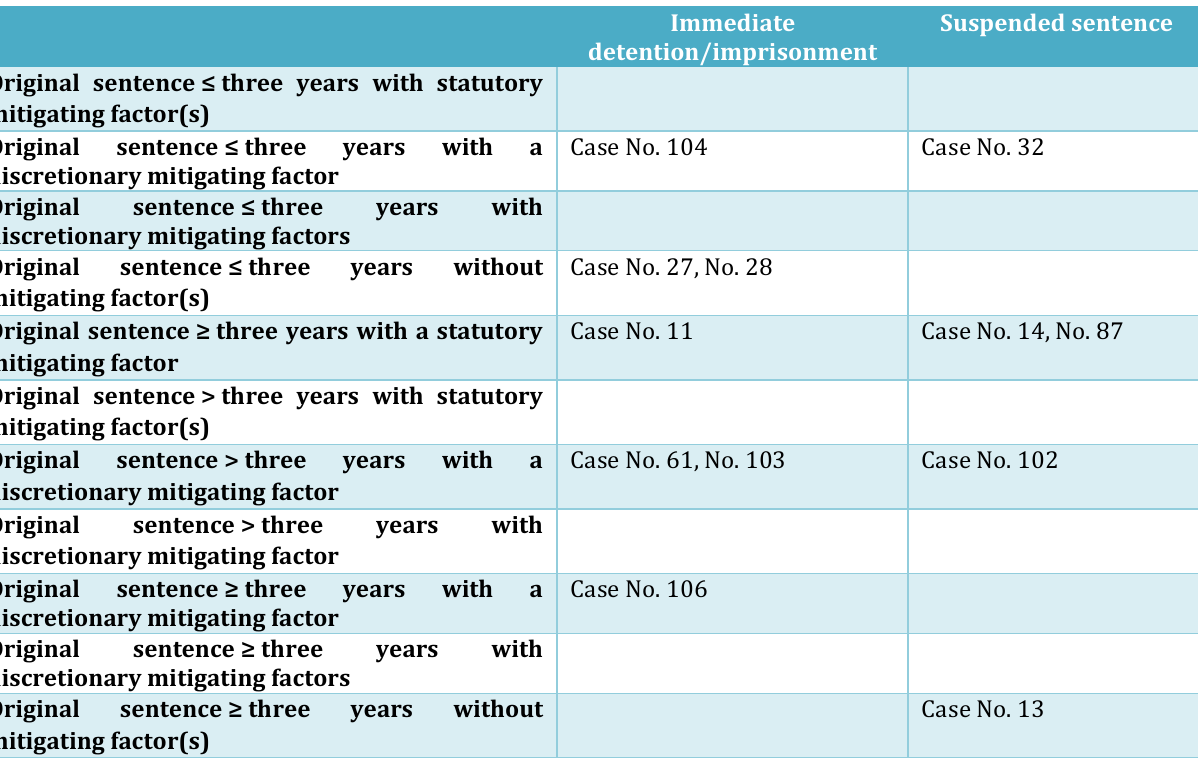
Table 3: Original sentence and mitigating factors for individuals sentenced to criminal detention or imprisonment of no more than three years under the Guiding Cases system